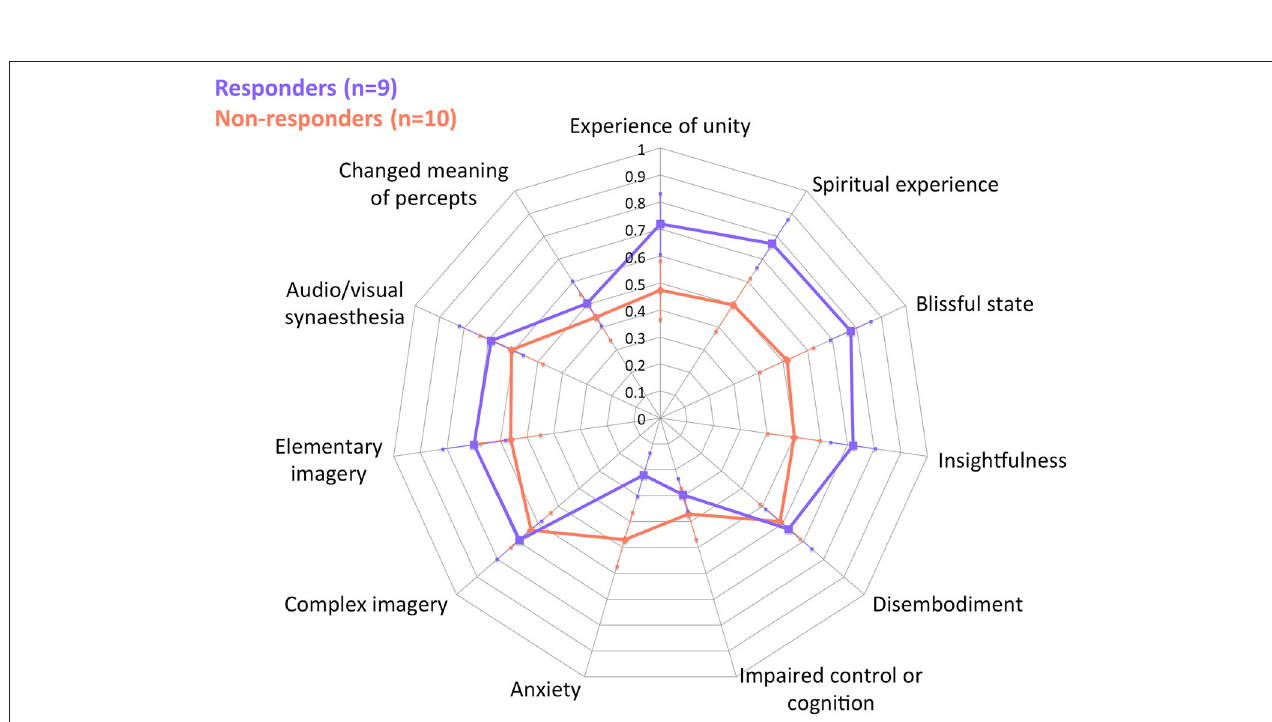
FIGURE 2 | ASC (11 dimensions) of responders and non-responders at 5 weeks. Error Bars = Standard Error.